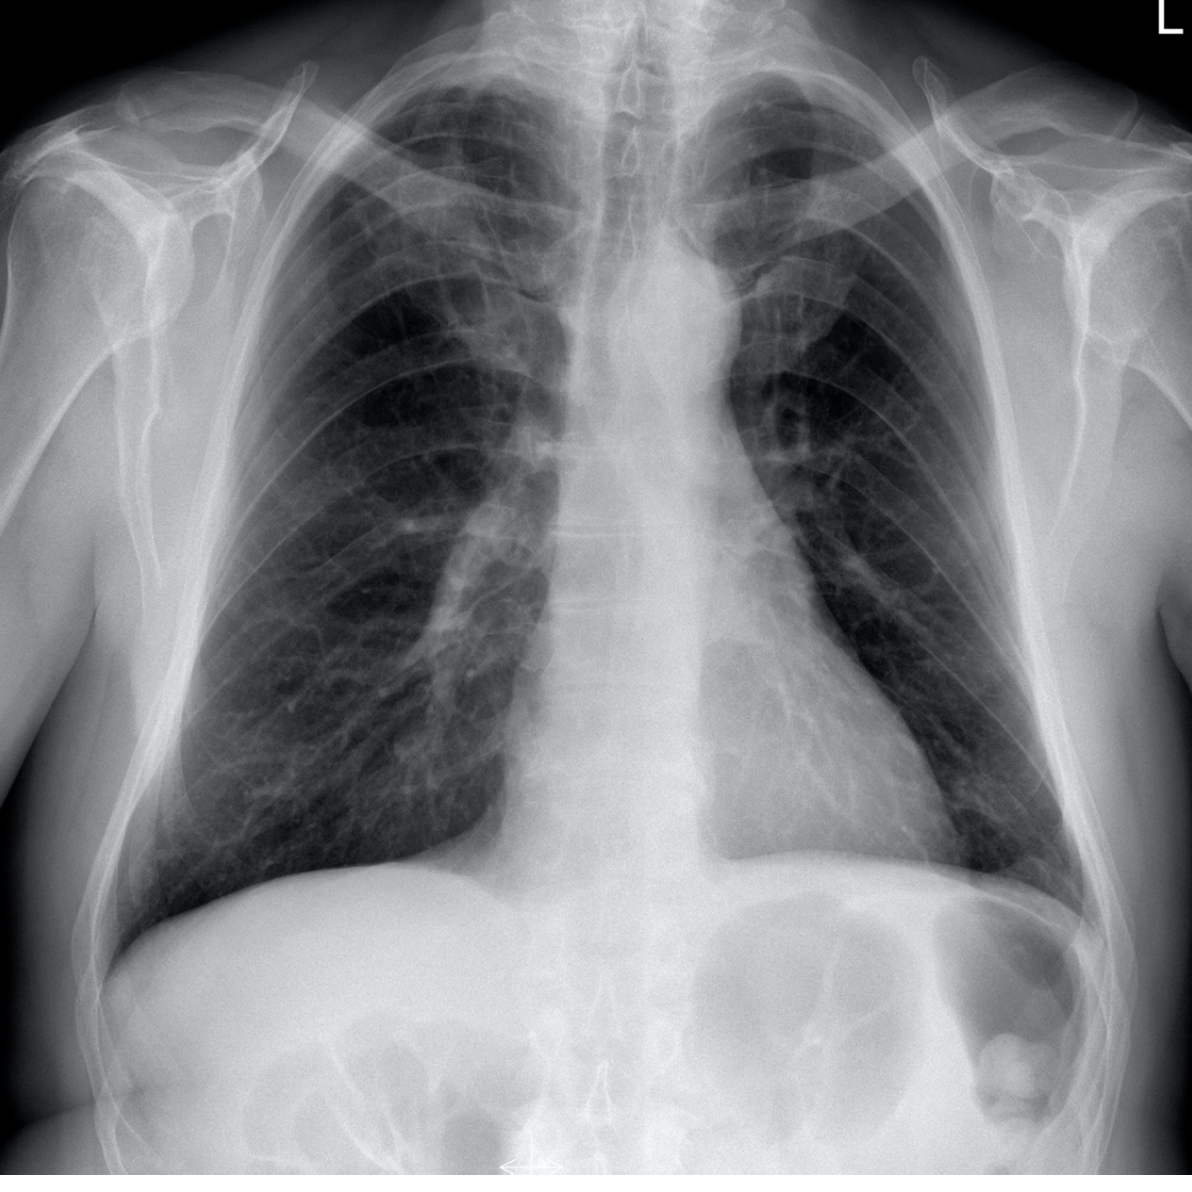
Figure 3. Postero-anterior chest X-ray showing complete regression of interstitial infiltrates and pleural effusion.